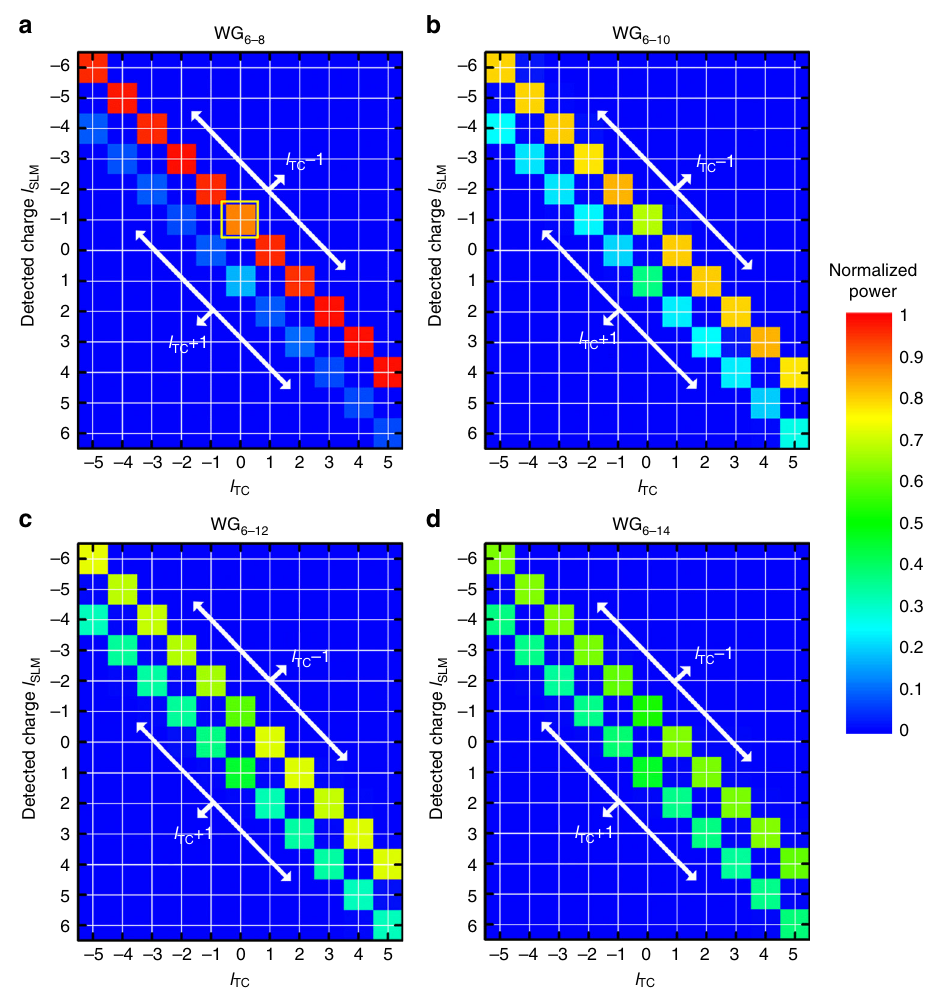
Fig. 6 Characterization of OAM components in CVVs. a – d The measured OAM spectra for the devices WG 6 – 8 , WG 6 – 10 , WG 6 – 12 , and WG 6 – 14 , respectively. For each device, the wavelengths of l TC = − 5 to + 5 are considered, and each column represents a spectrum of measured OAM components with the corresponding l